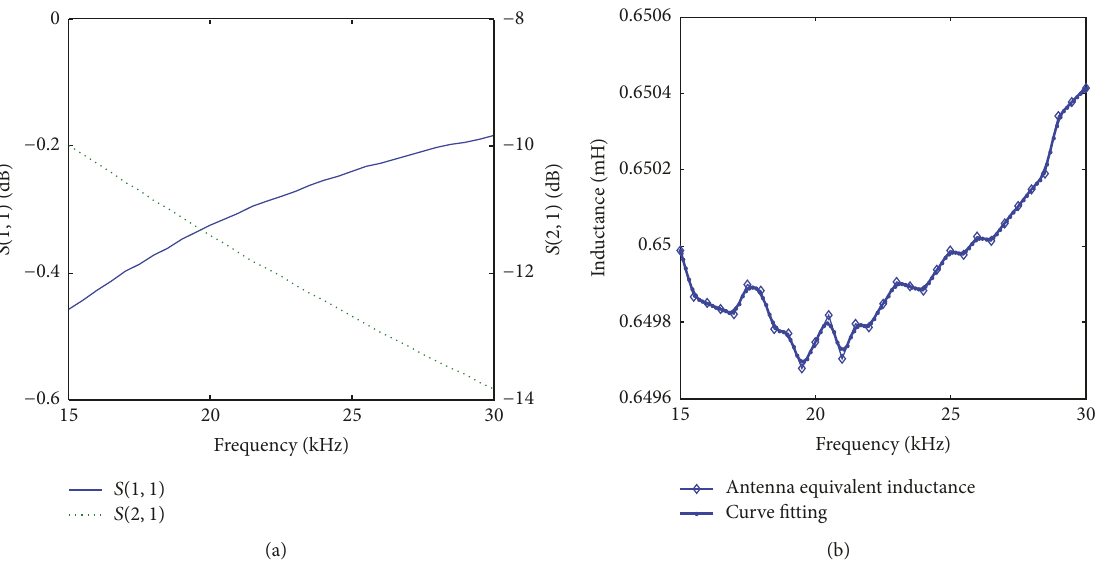
Figure 2: Loop receive antenna measurement data. (a) 𝑆 -parameters of the VLF loop receive antenna; (b) equivalent inductance of the VLF receive loop antenna.